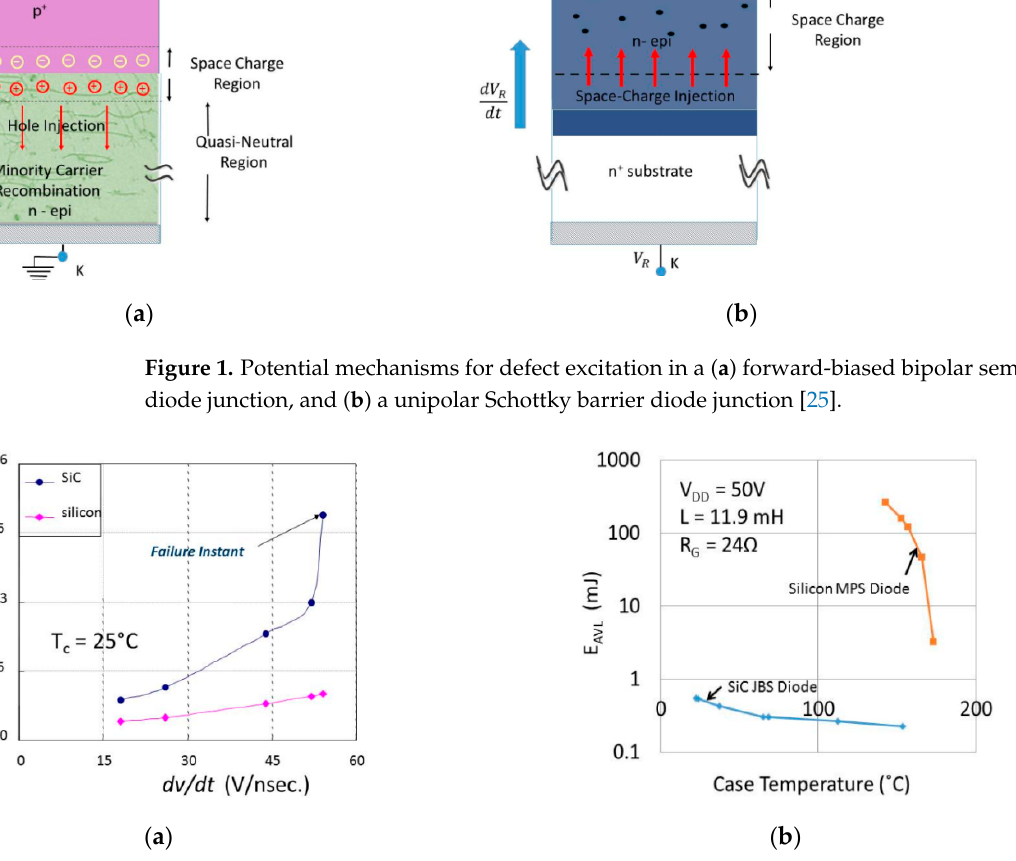
Figure 2. Measured ( a ) dv/dt capability and ( b ) avalanche energy of 600 V silicon and SiC power diodes [24].